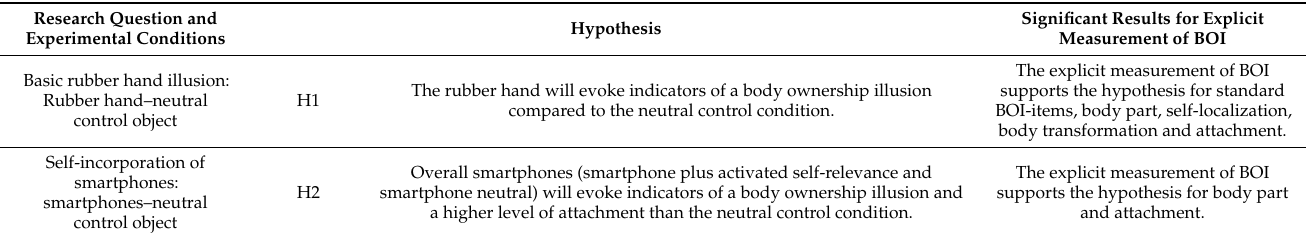
Table 4. Key research questions and findings. The table gives an overview of all experimental conditions aligned to the research questions and hypothesis they answer as well as a list of the significant results for the explicit measurements of